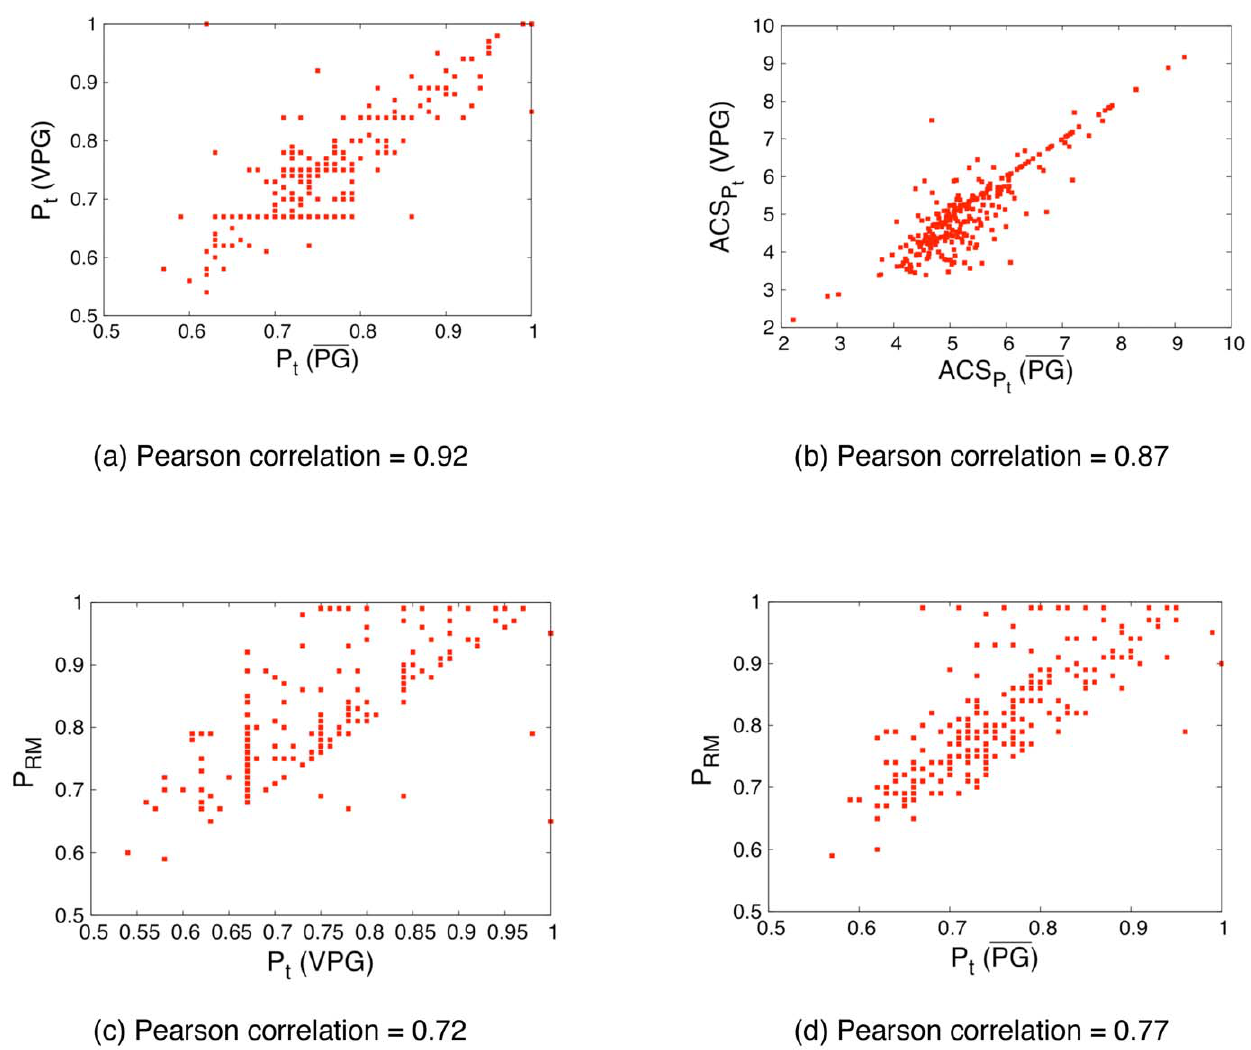
Figure 11. Rigidity transition effects. (a) The rigidity transition ( P t ) is compared across the PG and VPG algorithms. (b) Similarly, the average cluster size (ACS) at their respective P t values are compared across the two algorithms. The value of P nat with the worst RM (called P RM ) is compared to P t calculated using the (c) VPG and (d) PG . The linear relationships occur because the mean field approximation is maximally inaccurate in this range. Note, a few proteins do not have completed peaks in their rigid cluster susceptibility curves because the protein never crosses the rigidity transition, which have been excluded from panels (c) and (d).